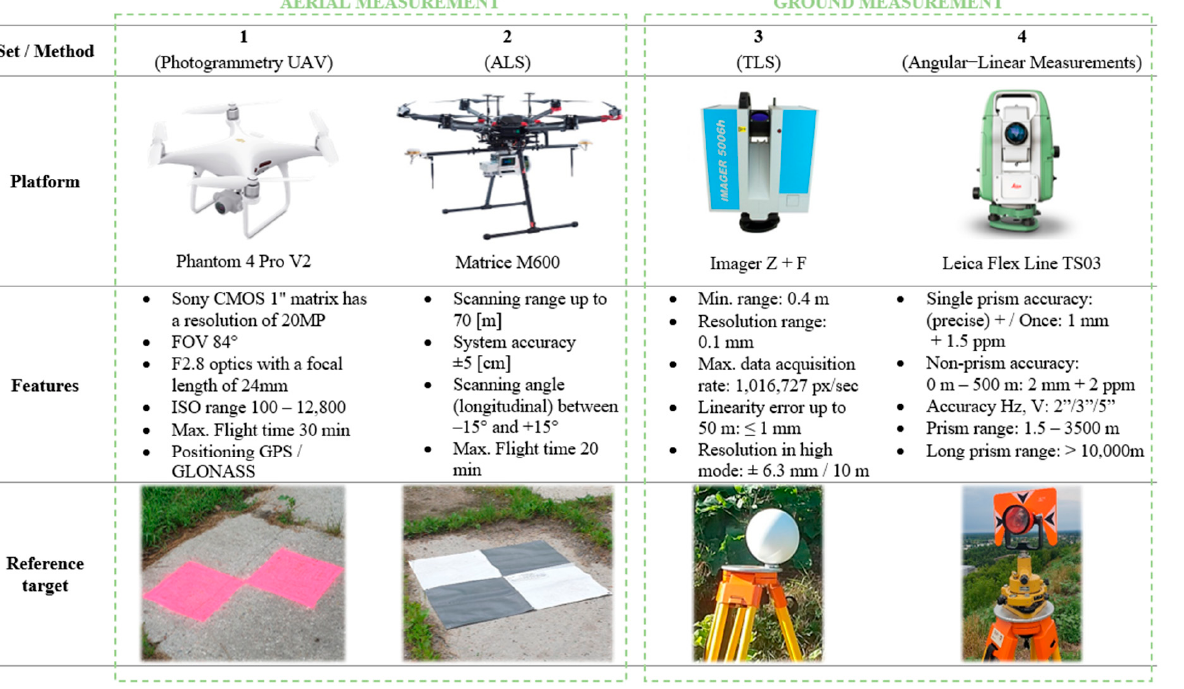
Figure 3. Overview of the research measurements. Developed based on [33–35]. Set 1: Digital images were obtained from a photogrammetric flight taken using a Phantom 4 Pro platform, which is equipped with a 1-inch, 20-megapixel CMOS sensor with a 24-mm FOV lens. The measurements were taken from a height of 60 m above the landfill crown. The BSP measurement was divided into five flights. During the first flight, vertical (nadir) images were taken. In the next four, flights were carried out with oblique photos in four different directions (north, south, east, and west). A total of 18 longitudinal and 18 transverse series were taken. Coverage of longitudinal and transverse images was 80% for nadir images and 50% for oblique images with an off-nadir angle of 30 ◦ . A total of 1768 images were acquired. In the field, before the flights, 13 ground control points (GCPs) were marked and their XYZ coordinates were measured. Their shape, color, and size enabled unambiguous identification of the points in the field. The point clouds from imaging data were generated using the Pix4D Mapper